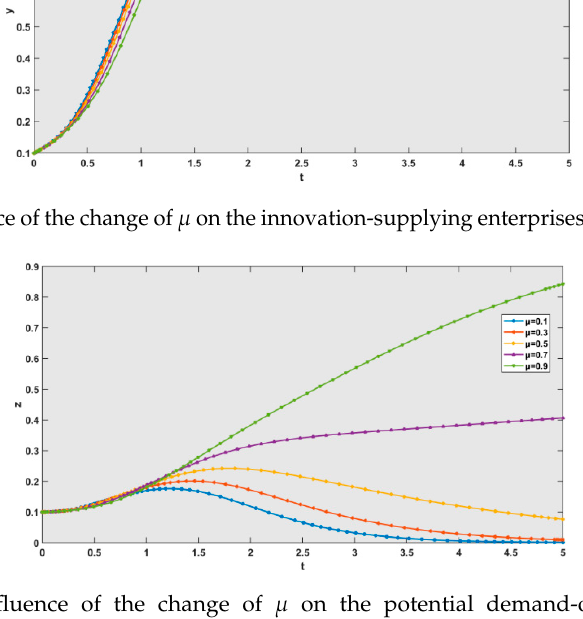
Figure 10. The influence of the change of µ on the potential demand-oriented enterprises’ evolution